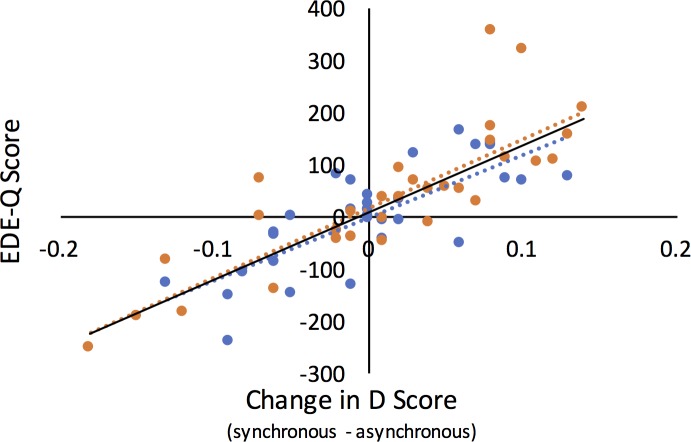
Synchrony x EDE-Q interaction.Increases in implicit body satisfaction (d score) correlated with EDE-Q score across body size conditions, in which relative increases in d scores corresponded with lower non-clinical cognitive-behavioural eating disorder characteristics (EDE-Q score). Female participants are represented by blue circles, and male participants are represented by orange circles. EDE-Q = eating disorder examination questionnaire.